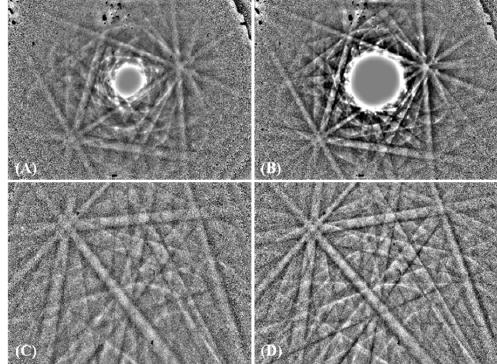
Figure 5. Kikuchi patterns of the 91-nm-thick sample at the voltages of ( A , C ) 20 and ( B , D ) 30 kV for the on-axis and off-axis TKDs, respectively.